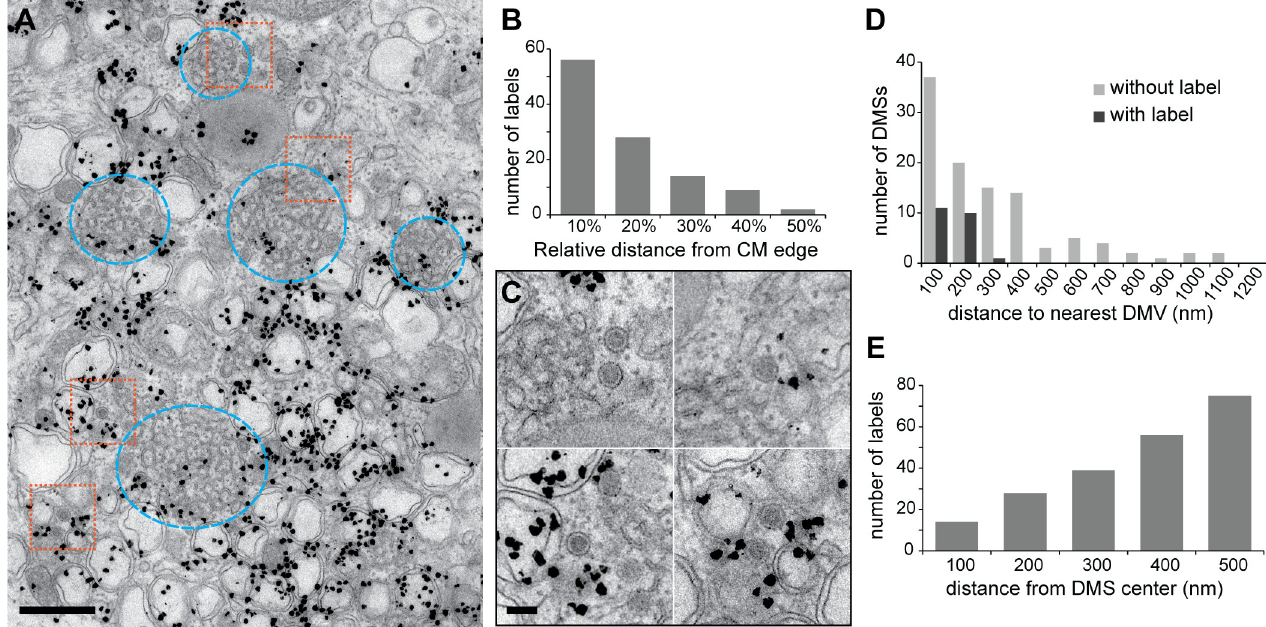
Fig 6. Newly synthesized vRNA signal does not clearly associate with CM or DMSs. (A) Overview of a cluster of MERS-CoV-induced membrane modifications in Huh7 cells prepared as described in Fig 5. Some DMSs are boxed in orange, and regions with CM are encircled in blue. In comparison with the densely labeled surrounding DMVs, these regions are relatively devoid of autoradiography signal. (B) The distribution of autoradiography grains on CM was not homogeneous ( n CM = 9), and label was predominantly found close to the boundaries of the CM, as expected if the signal arises from the surrounding DMVs. (C-E) Analysis of the label around/on the DMSs (see Materials and methods for selection criteria and details). (C) Enlargements of the DMS areas boxed in (A). Most DMSs were devoid of signal, and those who contained label were close to labeled DMVs (D) ( n around DMSs shows an increase in the amount of autoradiography grains with the distance from the DMS center, as expected from a random distribution ( n = 58). The underlying numerical data for the plots are in S5 Data. Scale bars, (A) 500 nm, (C) 100 nm. CM, convoluted membranes; DMS, double- DMSs membrane spherule; DMV, double-membrane vesicle; vRNA, viral